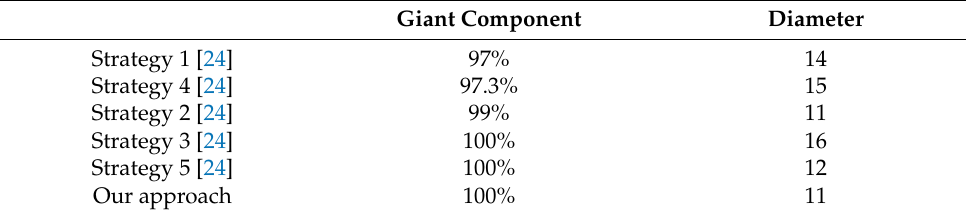
Table 5. Giant component and diameter comparison with the other